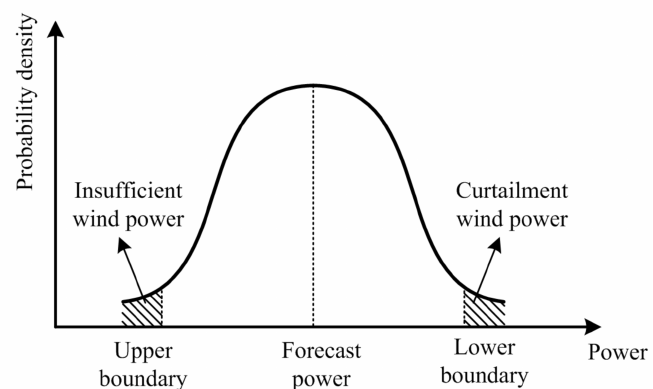
Figure 2. Probability density function of a wind